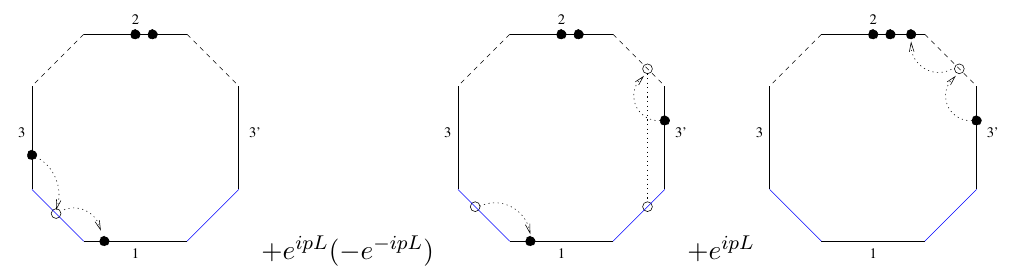
Figure 6 . Analytical continuation from domain #3 and #3’ back to domain